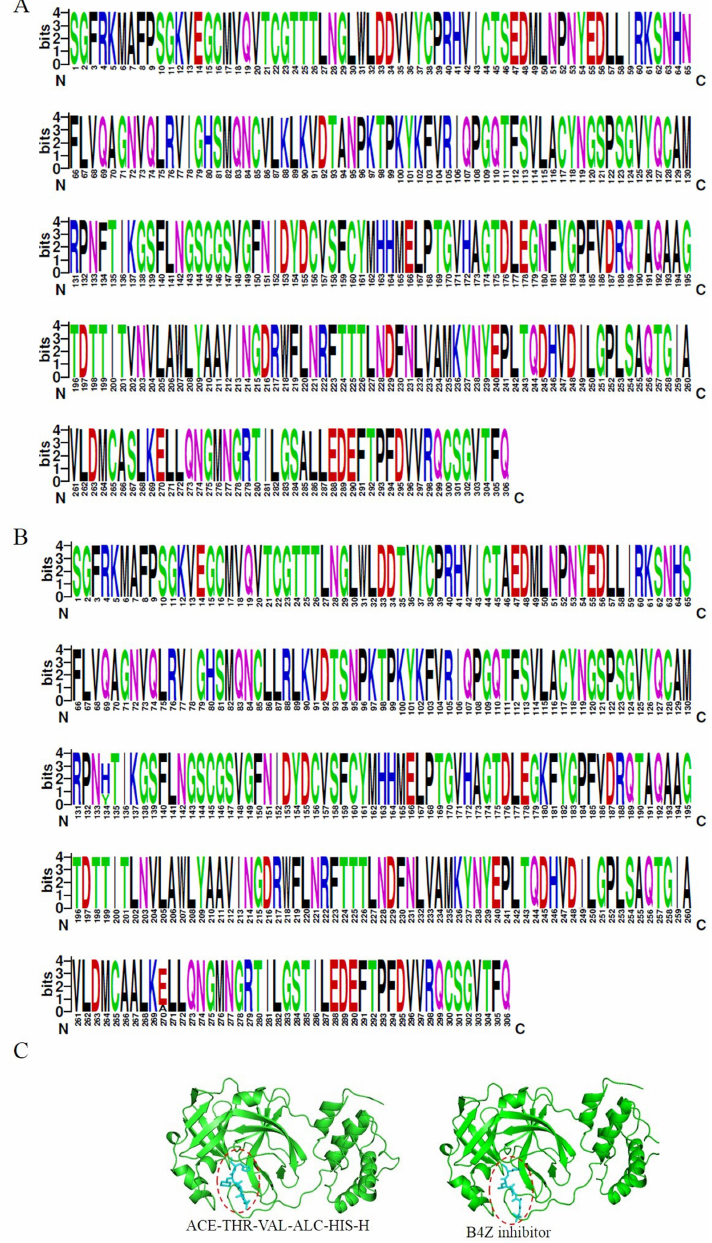
Figure 2. Sequence logos and inhibitors for Mpro in SARS-CoV-2 and SARS-CoV. (A) The sequence logo for Mpro in SARS-CoV-2; (B) The sequence logo for Mpro in SARS-CoV; (C) The complex for peptide and